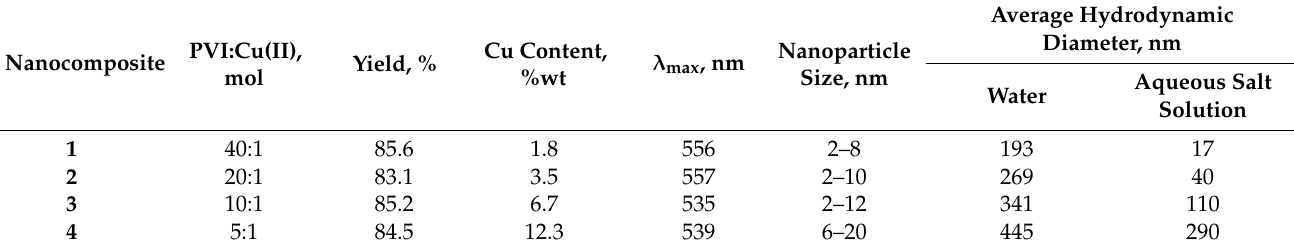
Table 1. Composition and characteristics of the nanocomposites with CuNPs 1–4